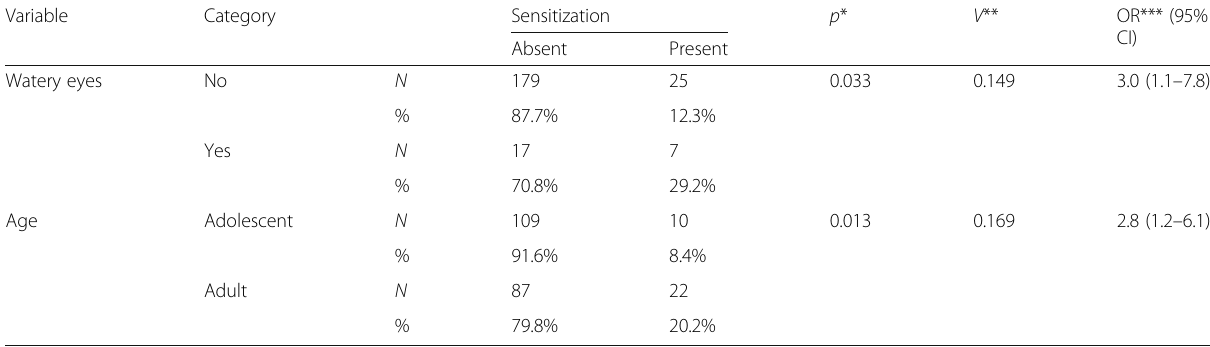
Table 2 Univariate predictors of nickel sensitization